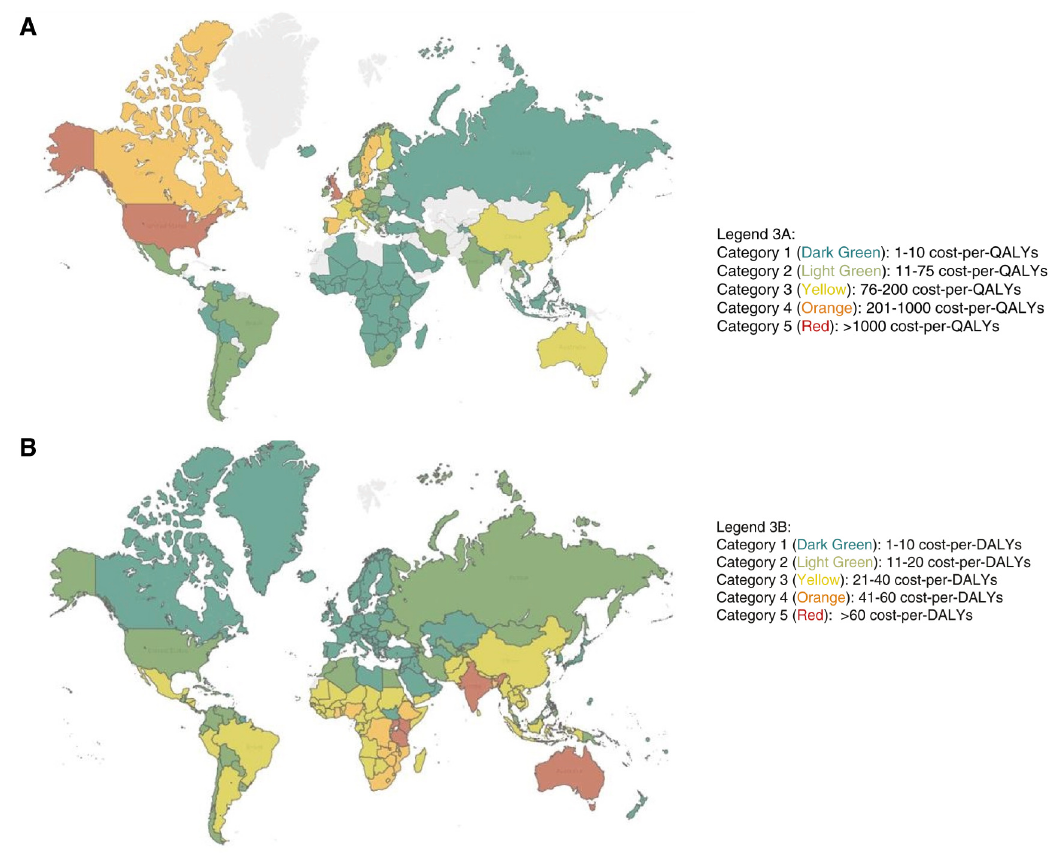
Figure 3. Geographic distribution of Cost-per-QALY and Cost-per-DALY studies. The maps present the number of cost-per-QALY studies (Figure 3A) and cost-per-DALY studies (Figure 3B) for each country. Gray indicates countries with no associated studies. If a study reported a cost-effectiveness estimate for two or more countries, we counted a CEA for each country (e.g. if a study reported an intervention’s cost- effectiveness ratio for both Canada and the United States, we incremented the study count in both countries). If a study reported a “global” cost-effectiveness ratio, we excluded it from all country counts. We also excluded from these counts studies that did not clearly specify an applicable country or